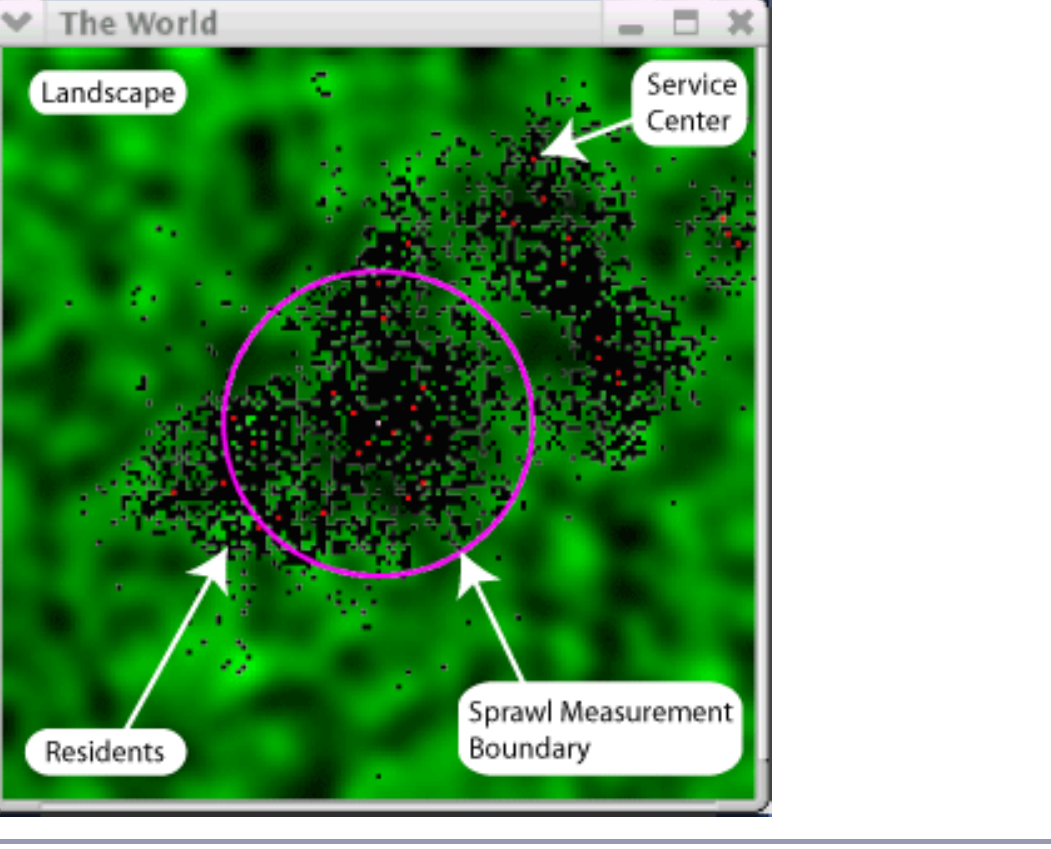
Fig. 1. Screen capture from a typical simulation run of the SOME model. The spatially autocorrelated and heterogeneous landscape is represented by shades of green, and brighter green represents higher aesthetic quality. The initial service center is located in the center of the landscape in yellow, and all other service centers are depicted in red. Residents are depicted using dark black squares. Last, the violet circle represents the boundary used in our sprawl measurements. The labels and circle were added for graphic illustration and are not displayed by typical model